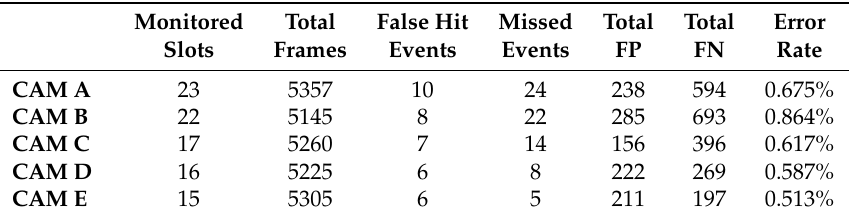
Table 1. Performance of parking lot monitoring of 5 separate devices.